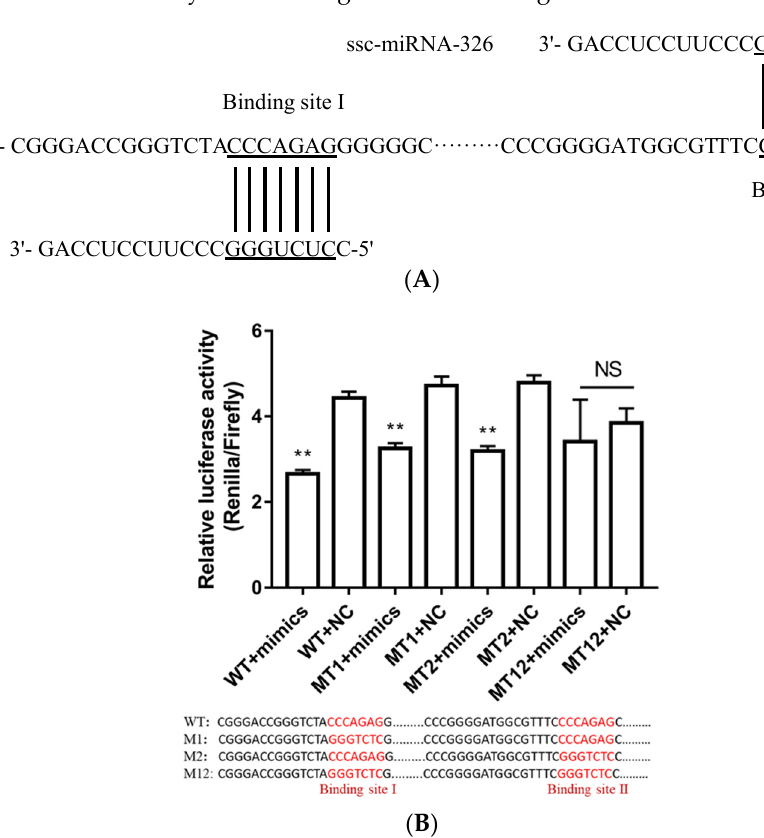
Figure 6. NKX3.2 inhibits chondrocyte differentiation. ATDC5 cells ( A , C ) and pig primary chondro- cytes ( B , D ) were cultured in chondrogenic differentiation media and treated with control pEGFP- N1 or pEGFP-N1- NKX3.2 -CDS. After 4 days, the cultures were stained with Alcian blue or har- vested for mRNA isolation and qPCR analyses of COL2A1 and COL10A1 expressions. Scale bar: 200 um. * p < 0.05, ** p < 0.01, Student’s t -test.